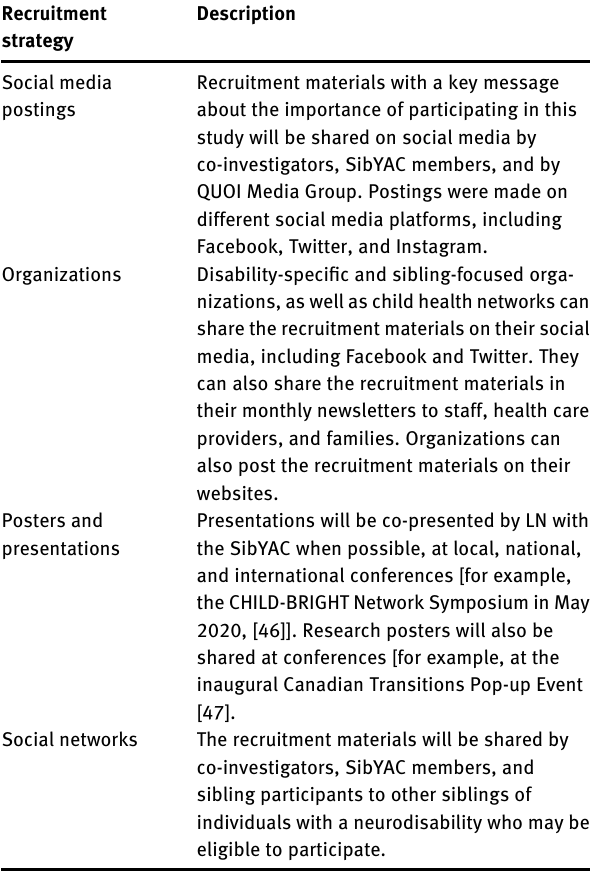
Table  : A description of recruitment